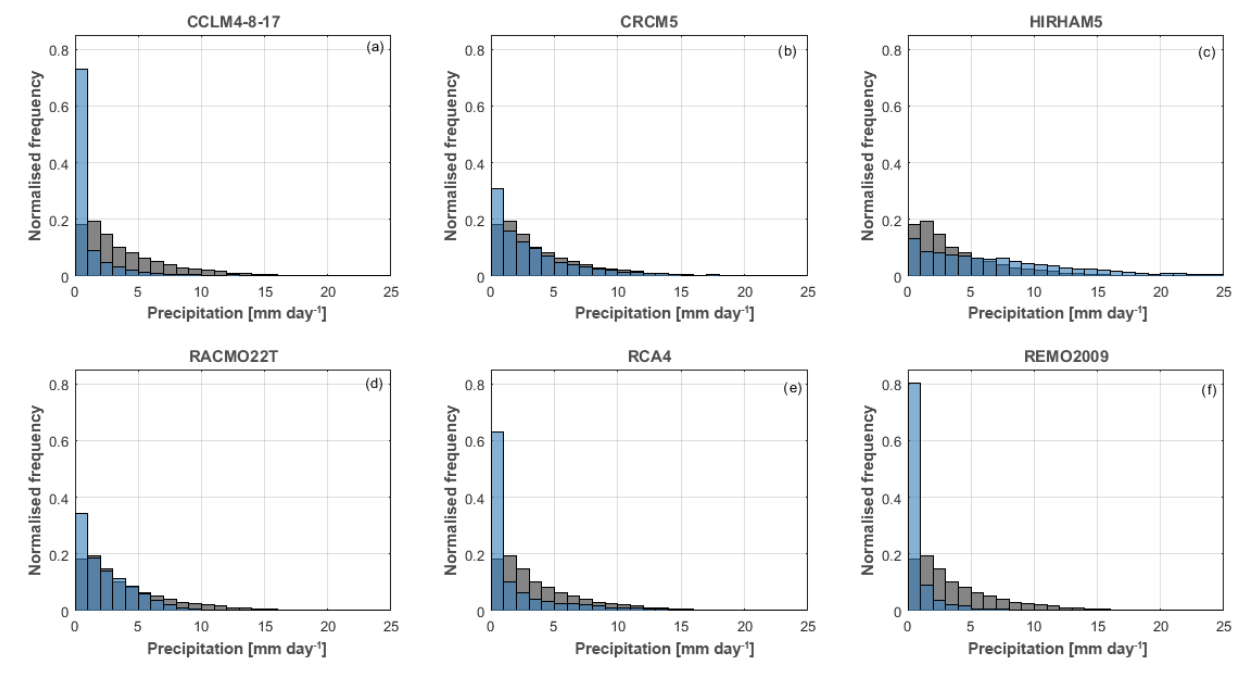
Figure 4. Histograms of lake precipitation derived from the CORDEX evaluation simulations for the period 1993–2008 (observed distribu- tions, derived from PERSIANN-CDR are indicated in grey).